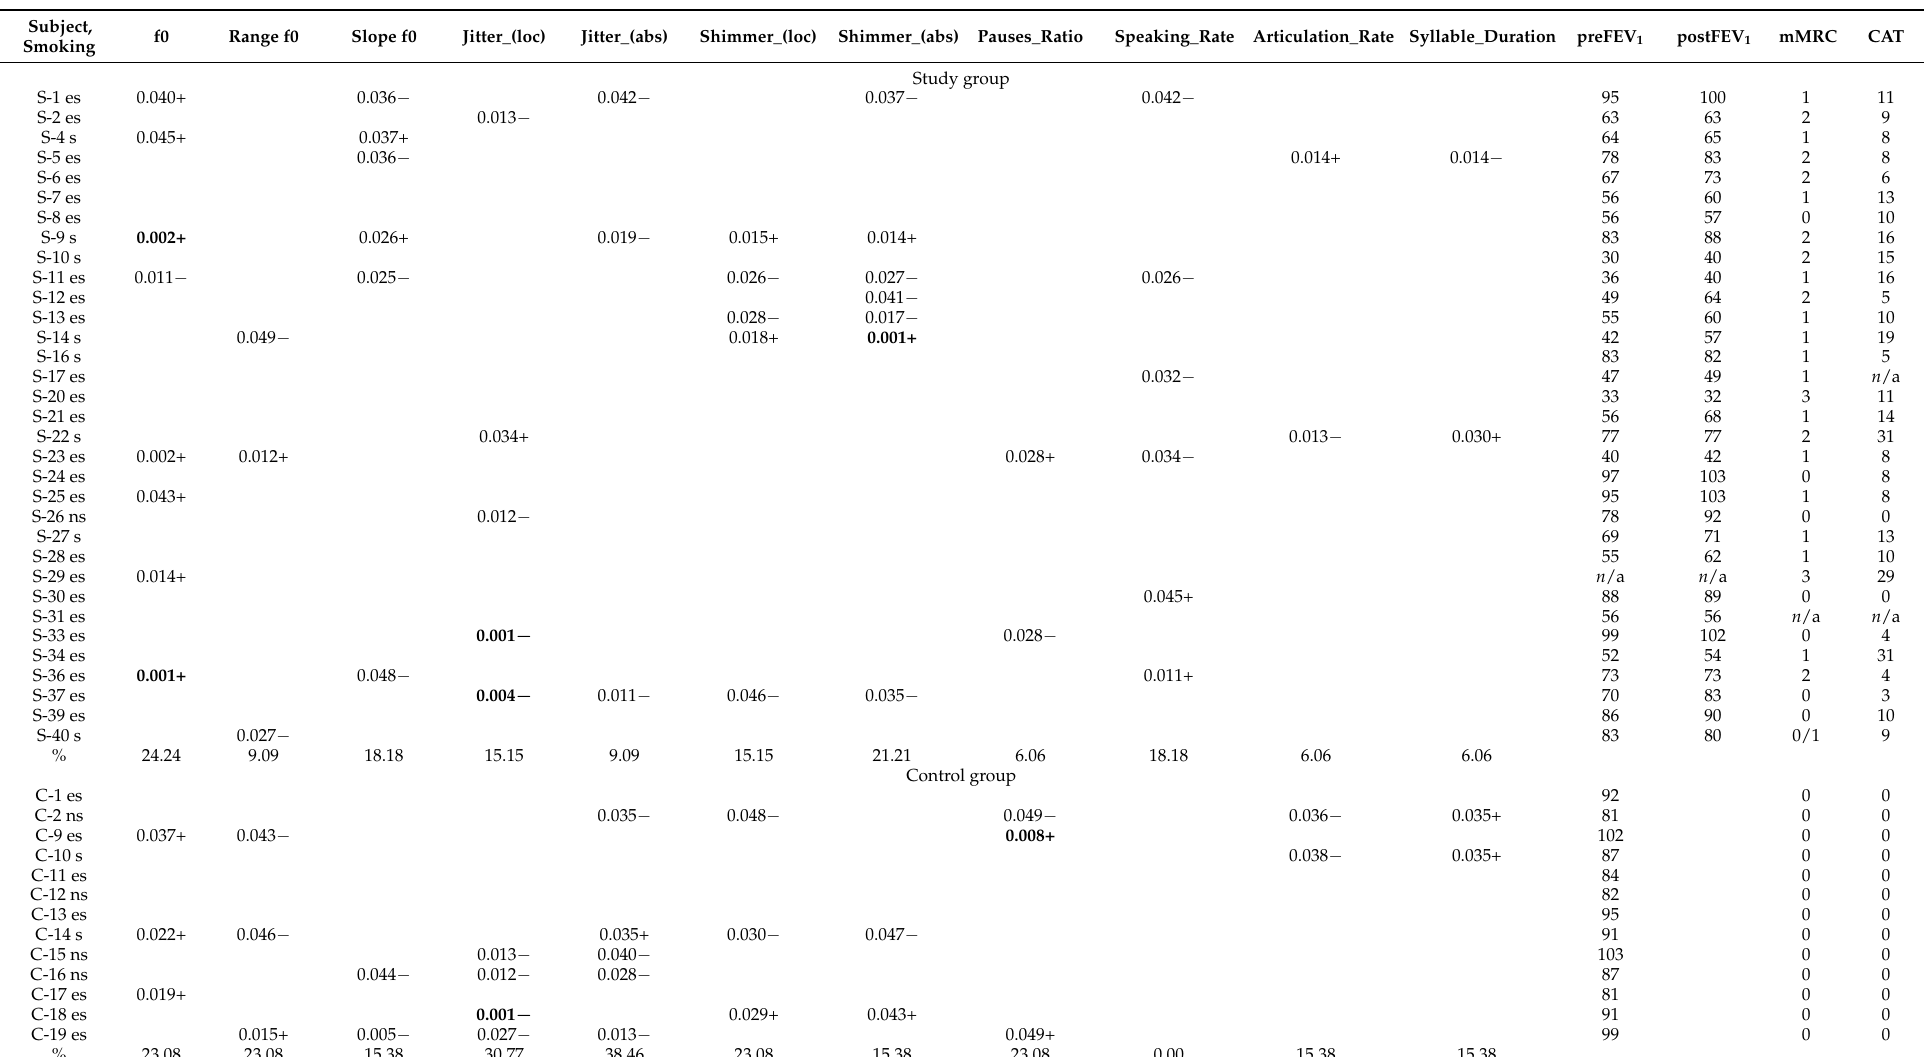
Table 3. Changes in speech features due to physical effort (study and control